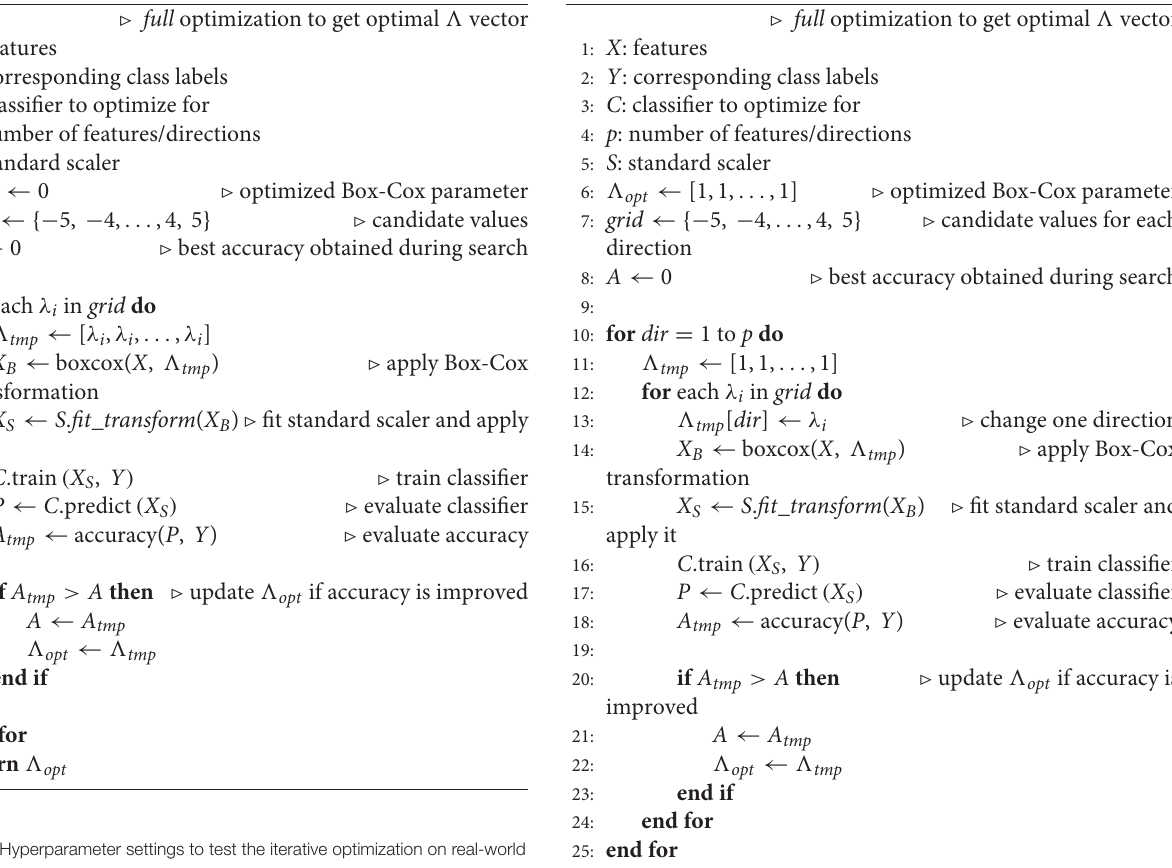
TABLE 4 | Hyperparameter settings to test the iterative optimization on real-world data.